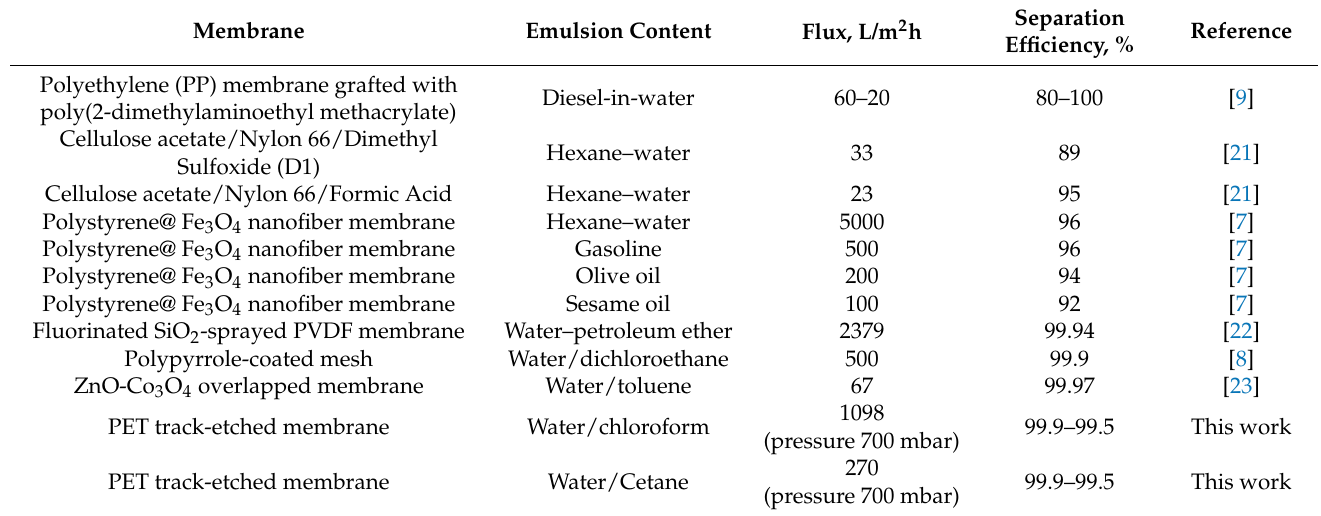
Table 5. Comparison of experimental results with other described in the literature.